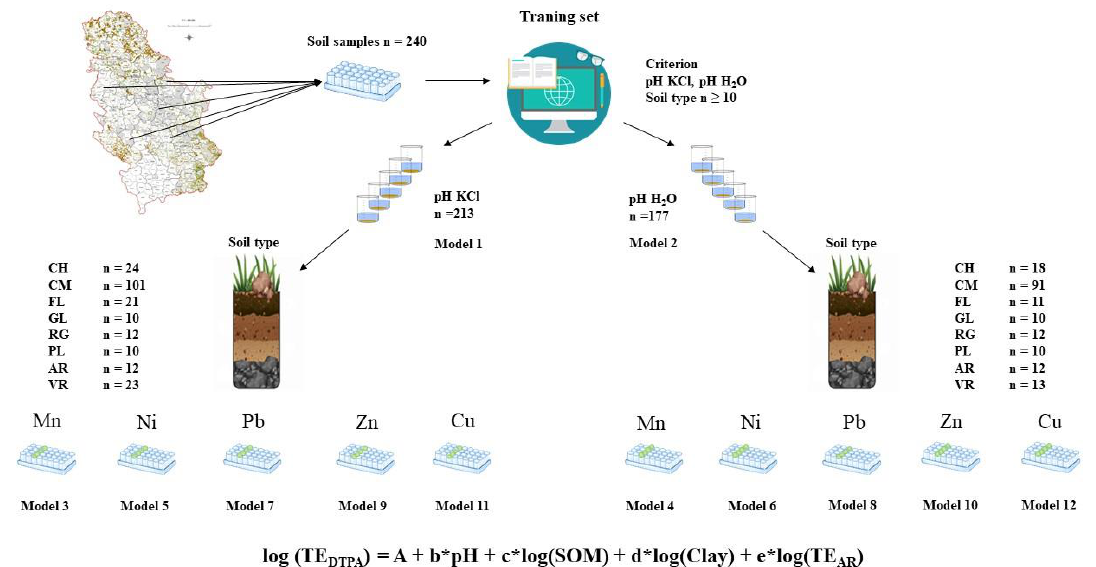
Figure 2. Schematic diagram of strategy for forming prediction models by soil types. CH–Chernozem; CM–Cambisol; FL–Fluvisol; GL–Gleysol; RG–Regosol; PL–Planosol; AR–Arenosol; VR-Vertisol.